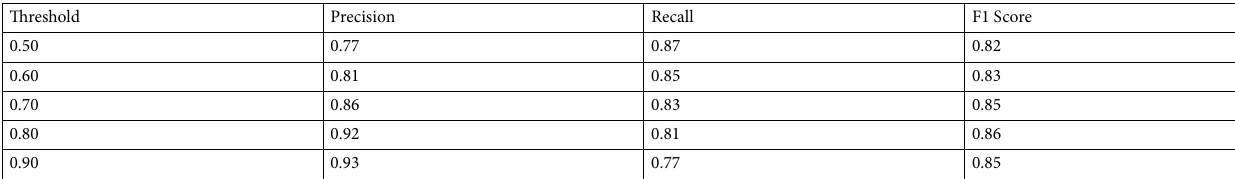
Table 1. Validation accuracy of mask prediction model from images with different decision thresholds. Precision is calculated as the proportion of predicted mask images that actually show a mask. Recall is the proportion of actual mask images predicted as a mask image. F1 score = 2 × (Precision × Recall)/(Precision + Recall).